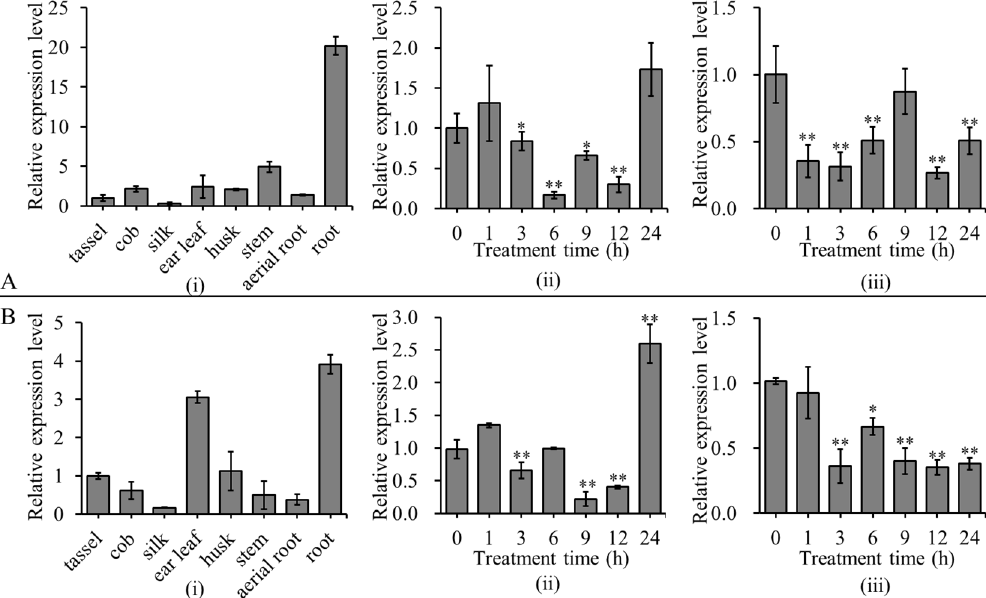
Figure 1. Expression patterns of ZmBES1/BZR1-3 ( A ) and ZmBES1/BZR1-9 ( B ). ( i ) Expression pattern in different tissues of maize. ( ii ); ( iii ) expression pattern in the shoot and root under drought stress, respectively. The three-leaf old seedlings of maize’s inbred line, B73, were subjected to 16% PEG-6000 to mimic drought stress. The relative expression level was calculated and normalized using the 2 −ΔΔ CT method of the CFX Manger™ software version 2.0 (Bio-Rad, Berkeley, CA, USA). * and ** represent p < 0.05 and p < 0.01 by the Student’s t -test, respectively.